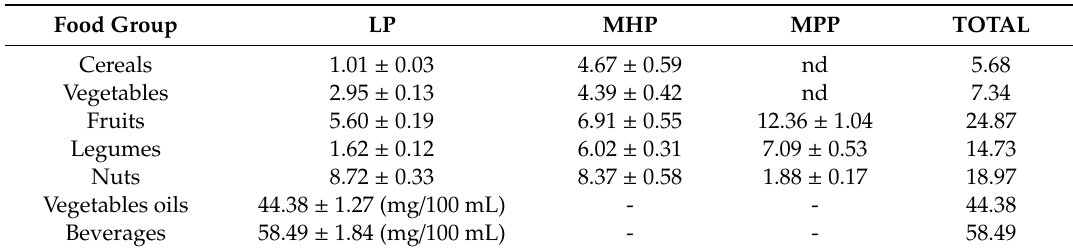
Figure 2. Contribution of plant foods to the intake of phenolic compounds in the total diet (LP: Low molecular polyphenols; MHP: Molecular hydrolysable polyphenols; MPP: Macromolecular polymeric polyphenols). Table 4. Phenolic compound content of plant foods in the diet consumed by an elderly population aged over 80 (mg/g original dry sample, mean ± standard deviation).